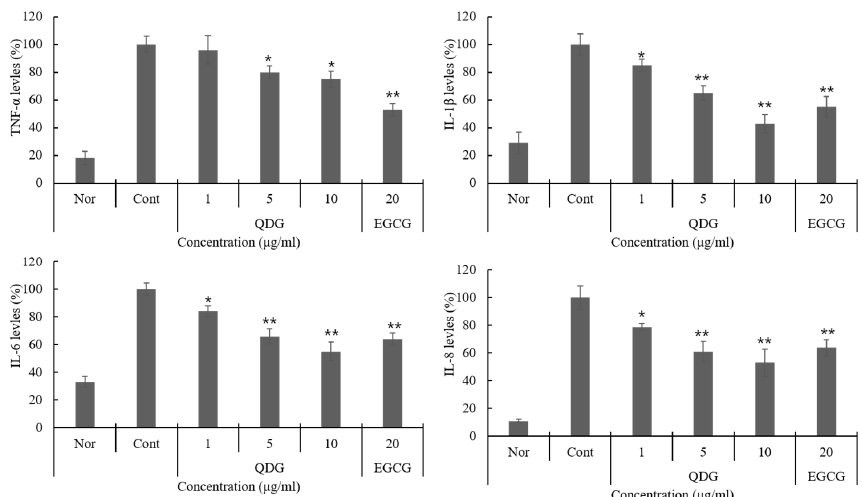
Figure 2. Effect of QDG treatment on cytokine expression in HaCaT cells. HaCaT cells were treated with different concentrations of QDG (1, 5, and 10 µ g/mL) after irradiation with 20 mJ/cm 2 UVB. After 24 h, cytokine expression was determined in the cell supernatant according to the kit manual. Each value represents mean ± SD for the three individual experiments. Nor: No treatment cell group (0 h), Cont: 20 mJ/cm 2 UVB treatment cell group, QDG = QDG treatment group, EGCG = positive control. n = 3, * = p < 0.001 and ** = p < 0.0001 compared with the control group.